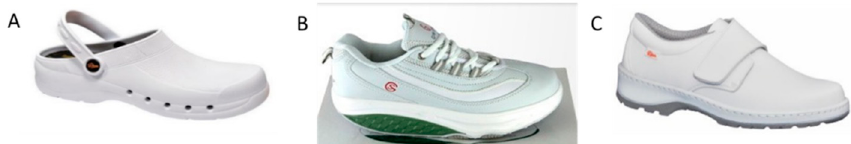
® , ( B ) Gym Step ® , ( C ) Milan-SCL Liso ®